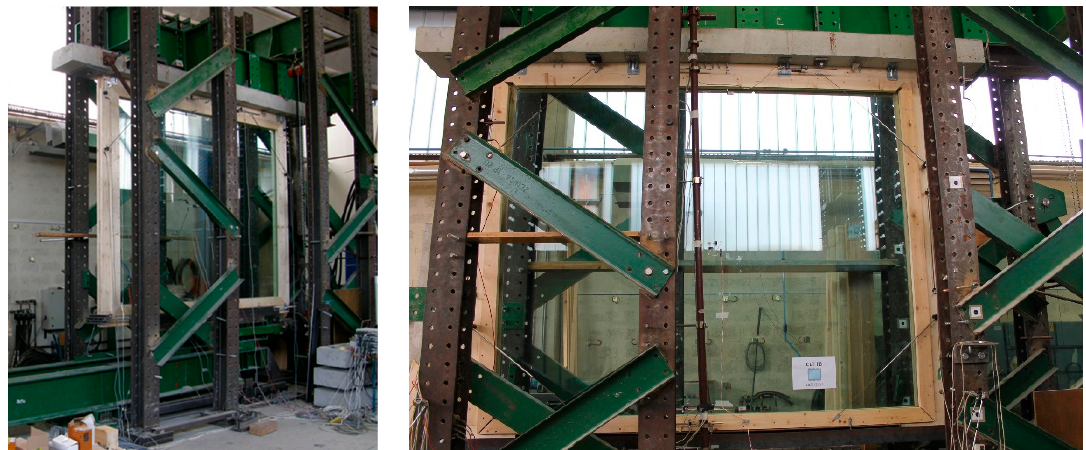
Figure 4. An example of a timber–glass composite system [39,40,88–94].